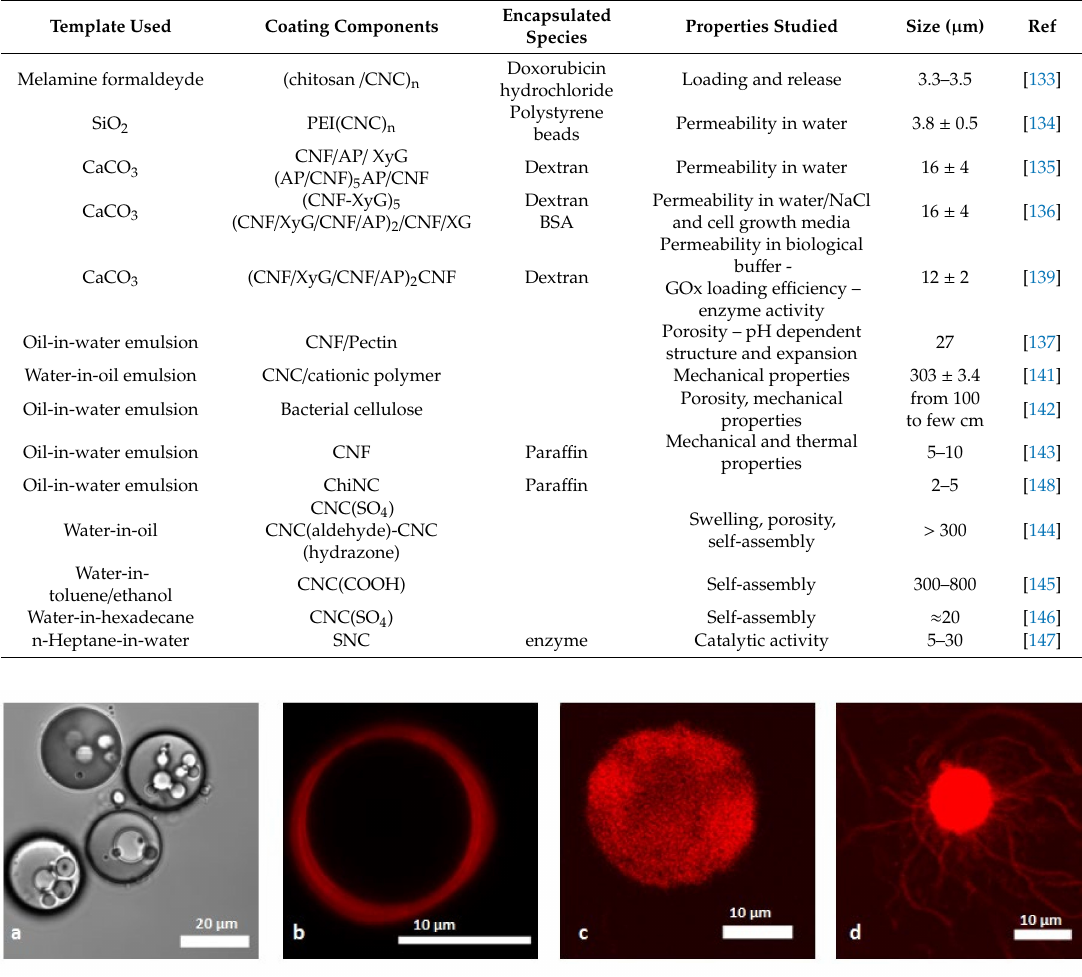
Figure 3. ( a ) Confocal Laser Scanning Microscopy (CLSM) images of microcapsules with lipid interior. ( b ) CLSM image of a single plantosome containing Rh-DOPE (red) in the lipid phase. ( c ) CLSM images of plantosome expanded in a 100mM NaCl solution after 1 h at pH 8.6. ( d ) CLSM images of a lipid tubular protrusions from expanded plantosomes. Adapted from ref